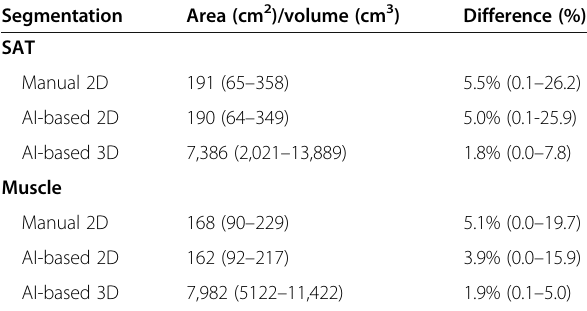
Data are given as mean and ranges (minimum – maximum). 2D Two- dimensional, 3D Three-dimensional, AI Artificial intelligence, SAT Subcutaneous adipose